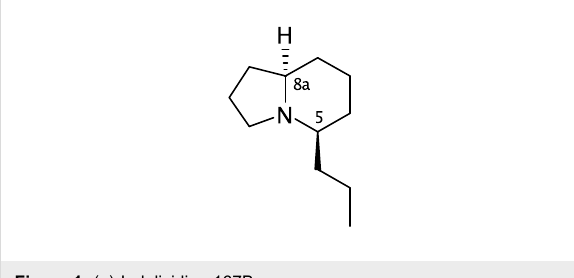
Figure 1: (–)-Indolizidine